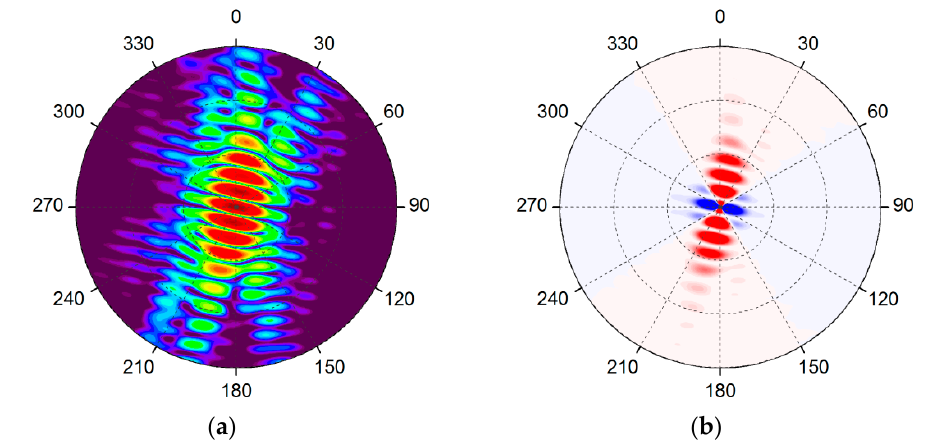
Figure 10. The same as in Figure 9 at coherent summation.